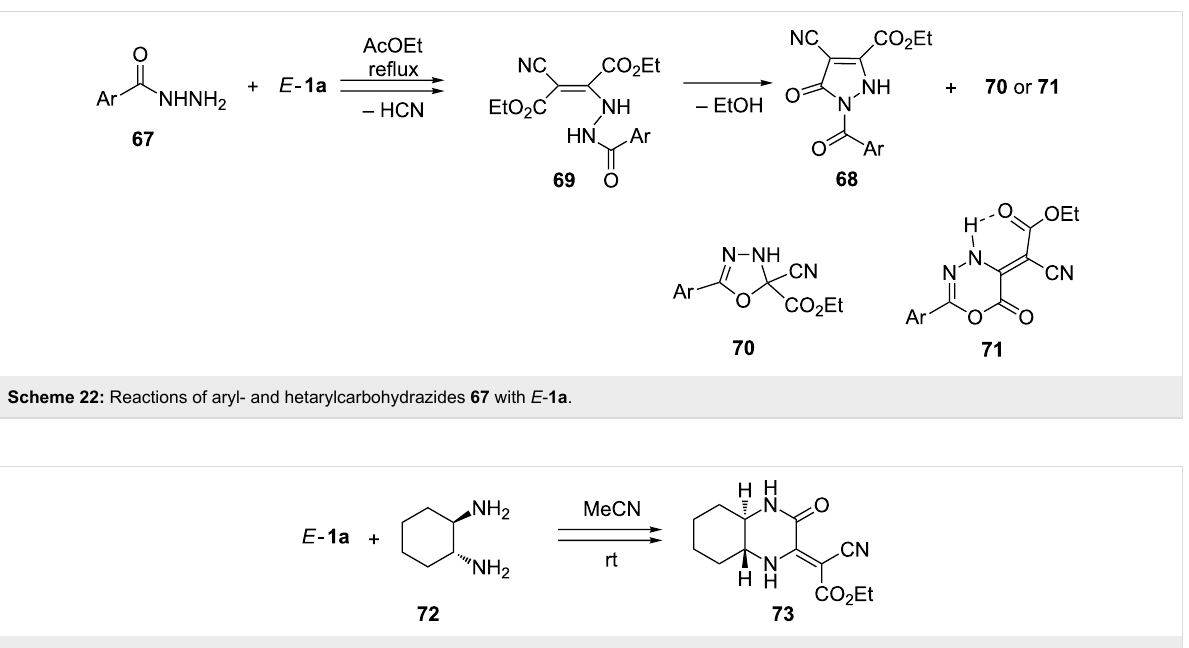
Scheme 23: Multistep reaction leading to perhydroquinoxaline derivative 73